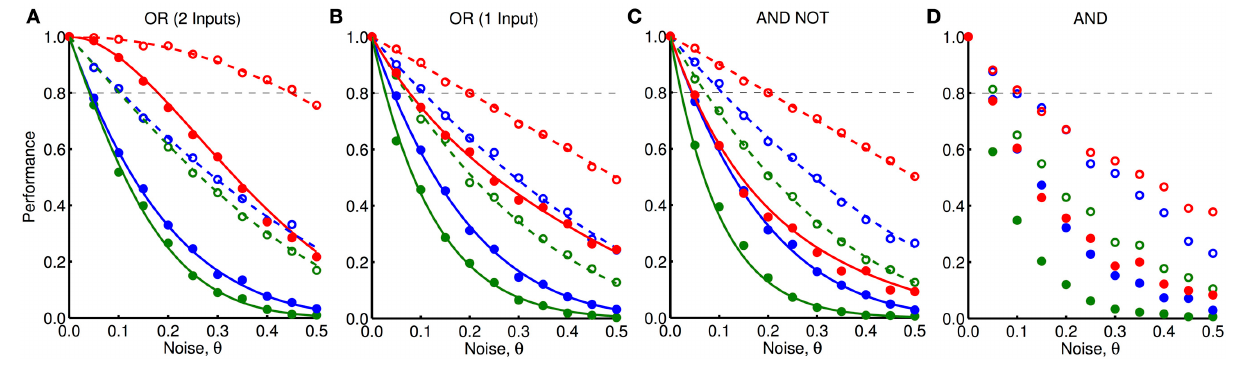
“peak-only noise” (dashed). Markers show the average outcome from 1000 simulations and lines show analytically derived curves. (B) Same as (A) but where one input is active and one is inactive. (C) Same as (A) but for the “AND NOT” network shown in Figure 3 where one input is active and one is inactive. (D) Same as (A) but for the “AND” network shown in Figure 3 where both inputs are active and without the analytically derived